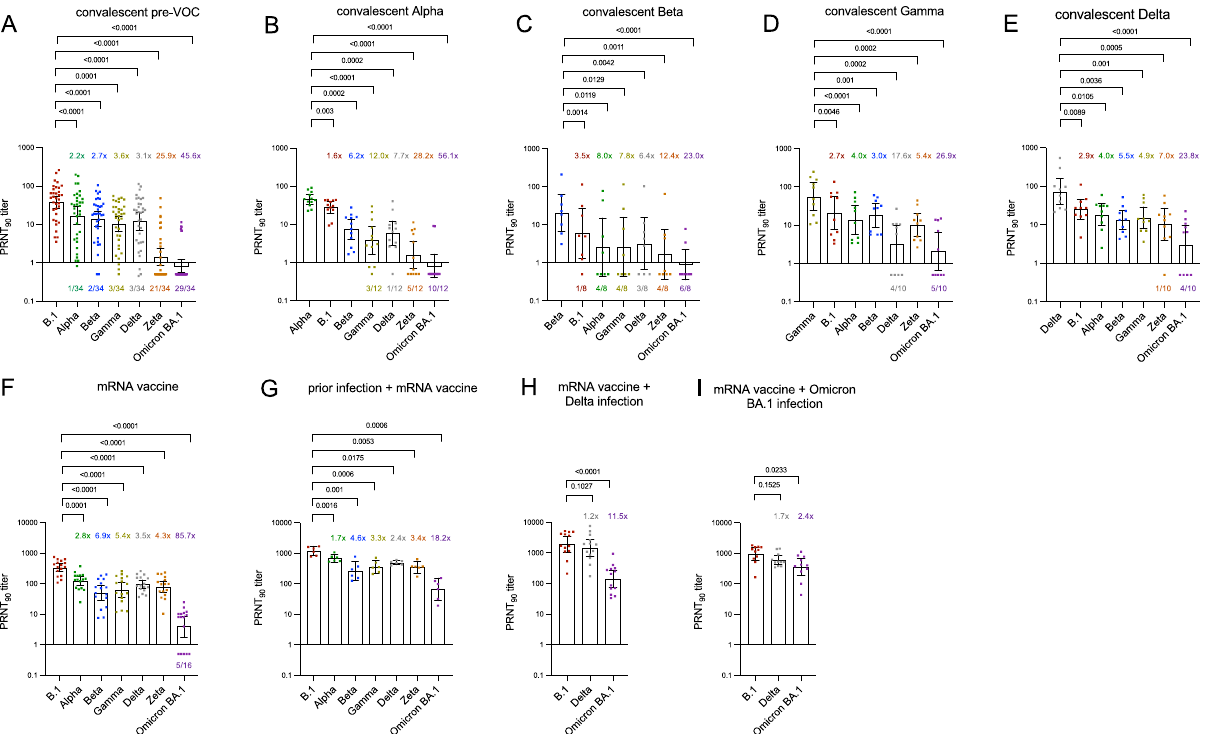
Fig. 1 Neutralization in infection-derived blood specimens against seven authentic isolates of SARS-CoV-2 variants (B.1, Alpha, Beta Gamma, Delta, Zeta, Omicron-BA.1). Bars represent geometric mean titers (GMT) of 90% reduction endpoint titers (PRNT 90 ) with 95% con fi dence interval. A – E Cohorts of convalescent specimens that are derived from individuals infected with A early-pandemic SARS-CoV-2 (pre-VOC), B Alpha, C Beta, D Gamma, and E Delta. F – I Cohorts consist of individuals with F double-dose mRNA vaccination, G prior SARS-CoV-2 infection followed by double-dose mRNA vaccination H Delta breakthrough infection of double-vaccinated individuals and I Omicron-BA.1 breakthrough infection following double ( n = 8) and single ( n = 3) mRNA vaccination. Colored numbers above bars refer to fold change reduction of GMT versus the homologous (infecting) variant, shown as fi rst bar of each fi gure. Colored numbers below each bar represent the number of specimens with complete loss of neutralization (PRNT 90 titer < 1). Repeated measures one-way ANOVA with Dunnett ’ s multiple comparisons test using log10 transformed PRNT 90 titers was performed to analyze the statistical signi fi cance. Source data are provided as a Source Data fi